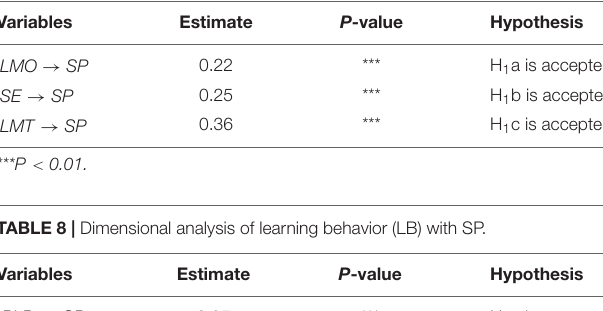
TABLE 7 | Dimensional analysis of mobile learning (ML) with student performance (SP).